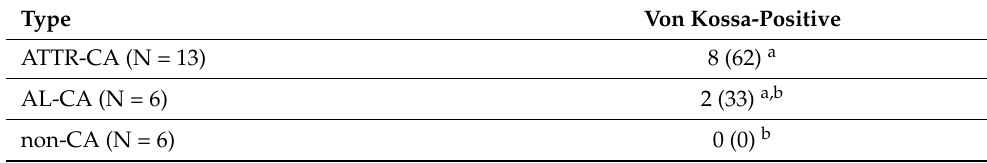
Table 2. Percentage of von Kossa-positive samples.